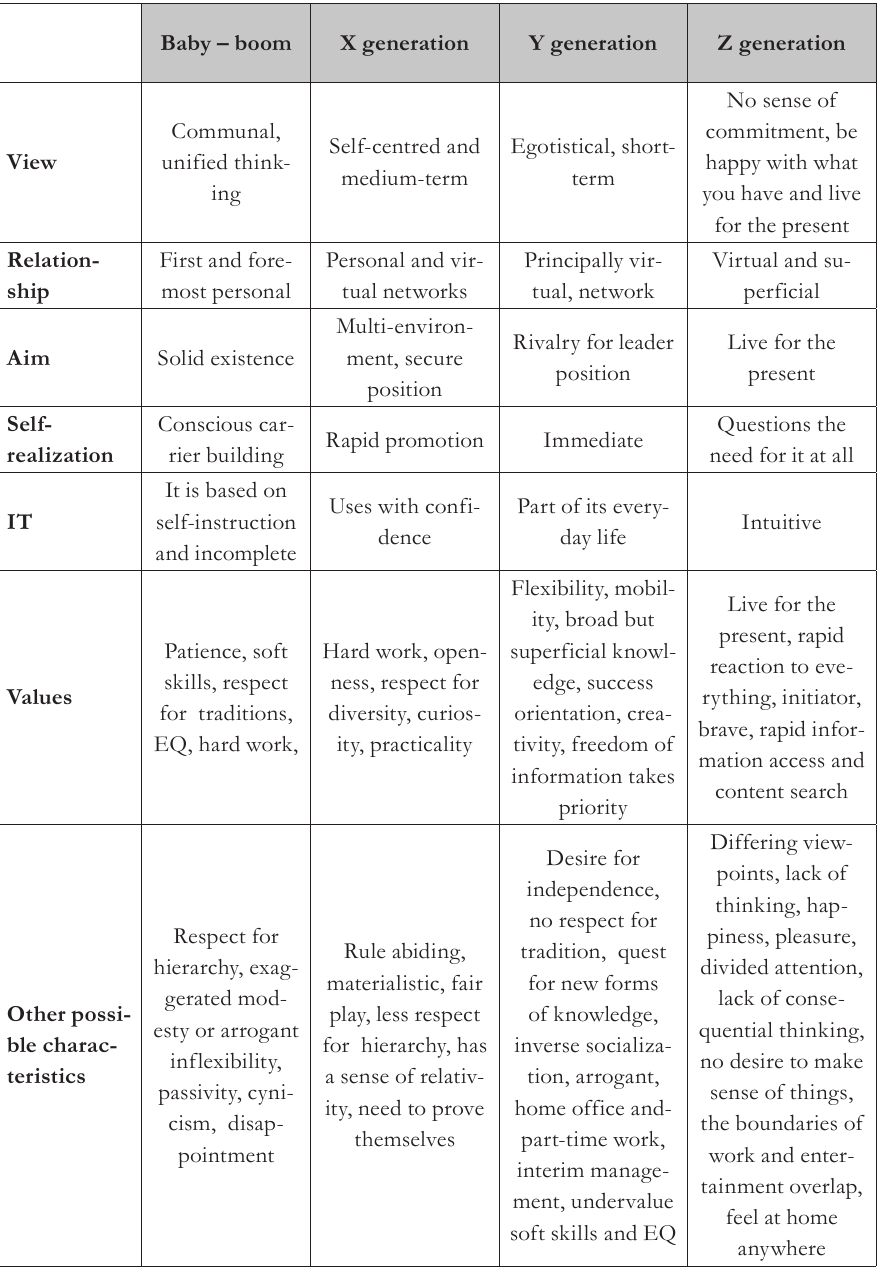
Tab. 2 - Generational behavioural characteristics of different age-groups Source: Bencsik & Machova,